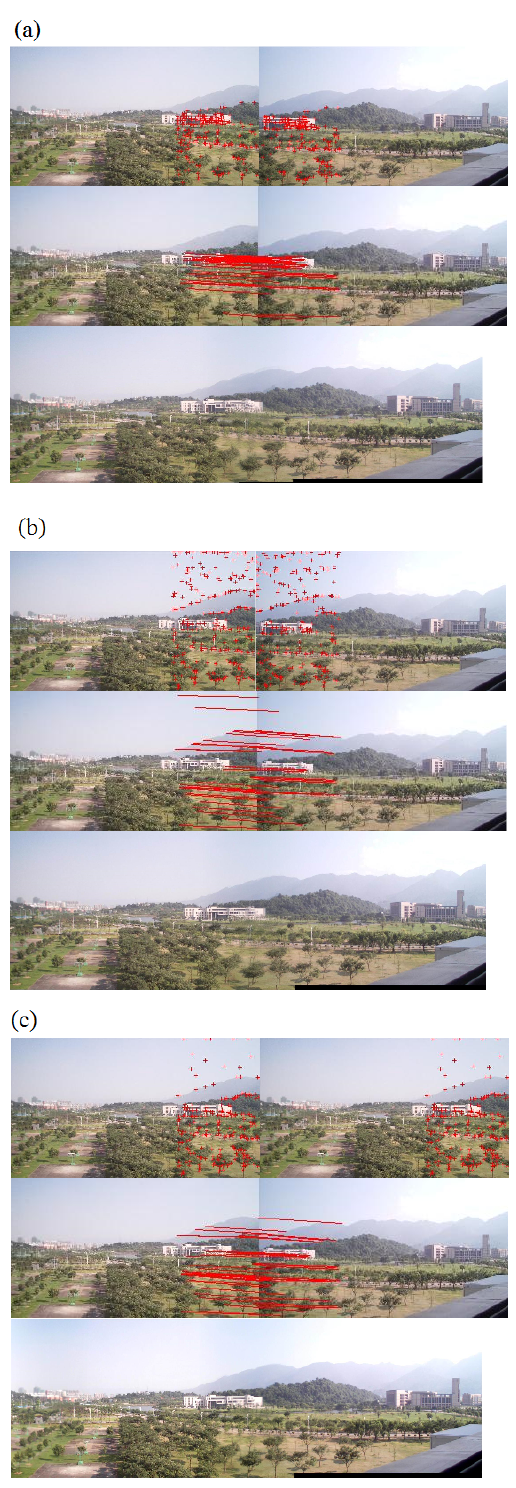
Figure 7. Comparison of stitching results from three different algorithms (II): (a) Traditional Harris detector; (b) The regional corner-selection algorithm in [ 9 ] ; (c) Our presented algorithm.